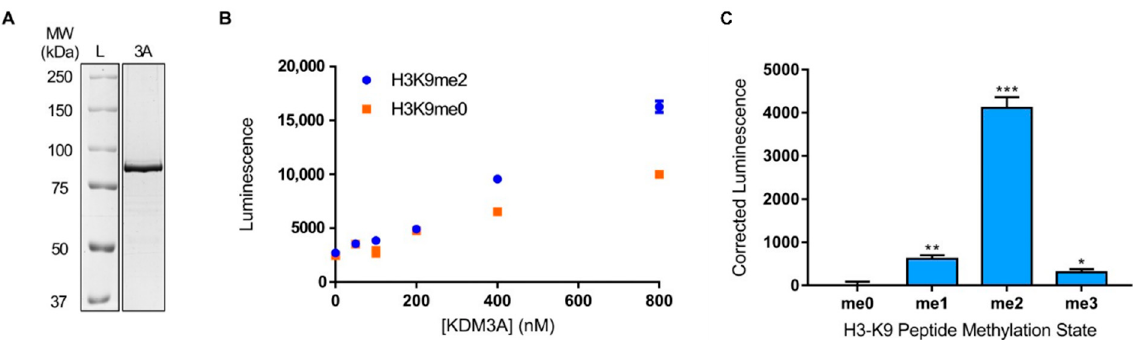
Figure 2 . Confirmation of KDM3A purity, non ‐ saturating enzyme concentration, and methyl ‐ state preference. ( A ) Purity of recombinant KDM3A shown via Coomassie staining. ( B ) Titration of re ‐ combinant KDM3A enzyme using 10 μ M of H3 2 ‐ 16 ‐ K9 null (orange) and di ‐ methylated (blue), 10 μ M Fe(II)SO 4 , 100 μ M ascorbic acid, and 10 μ M 2 ‐ oxoglutarate at 23 °C for 3 h. ( C ) Validation of KDM3A methyl ‐ state preference. KDM3A methylation state preference using 10 μ M of H3 2 ‐ 16 K9 peptides of varying methylation states in the presence of 600 nM enzyme, 10 μ M Fe(II)SO 4 , 100 μ M ascorbic acid, and 10 μ M 2 ‐ oxoglutarate at 23 °C for 3 h. Asterix denotes significance compared to me0 pep ‐ tide where * p ≤ 0.05, ** p ≤ 0.01, and *** p ≤ 0.001.